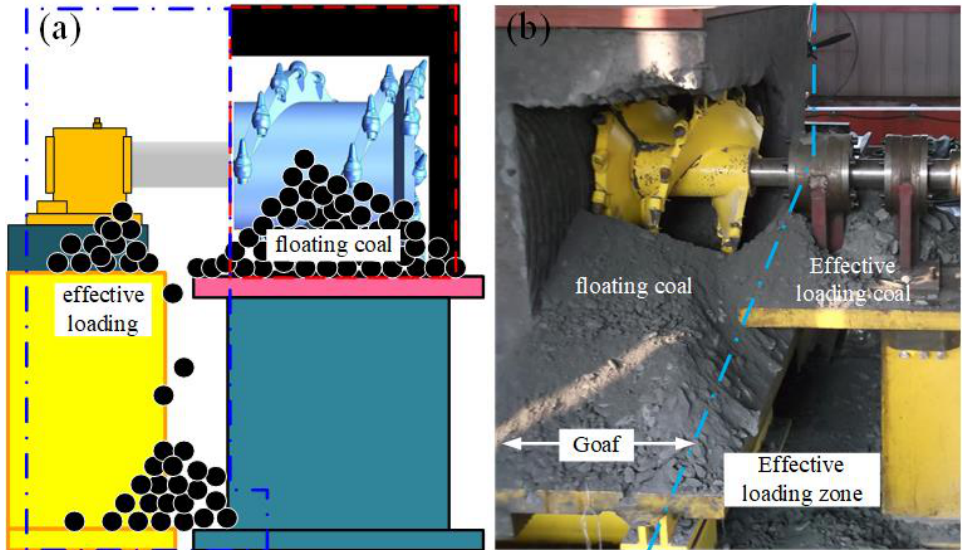
Figure 10. The distribution of coal particles in coal-loading tests: ( a ) schematic diagram; ( b ) experi- mental distribution.